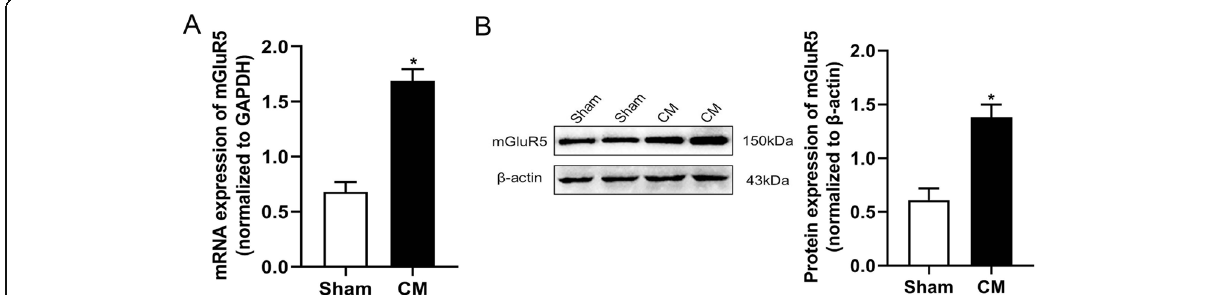
Fig. 2 Repeated IS infusions upregulated the mRNA and protein expression of mGluR5 in the TNC of rats. a The mRNA expression of mGluR5. b The protein expression of mGluR5. ( n = 4 in each group; * p < 0.05 compared with the sham